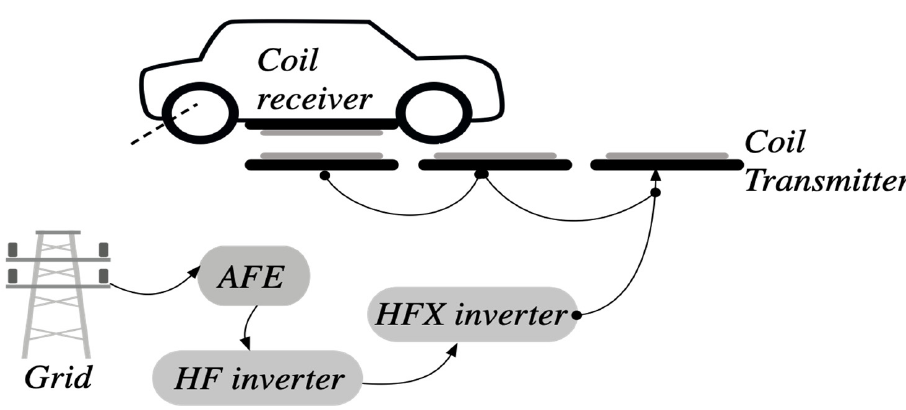
Figure 2. Different needed blocs for the overall WPT system.